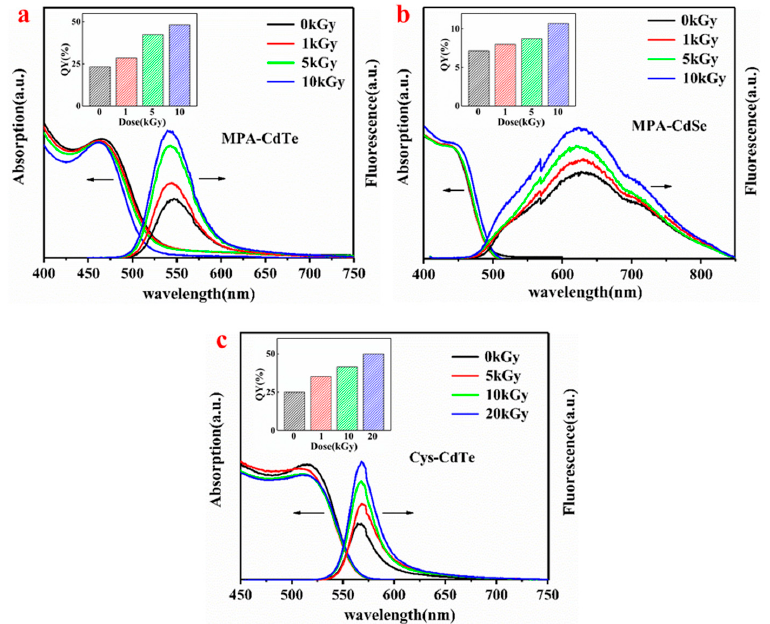
Figure 2. UV-vis, photoluminescence (PL) spectra and quantum yield of MPA-CdTe ( a ), MPA-CdSe ( b ) and Cys-CdTe ( c ) QDs under different radiation doses.